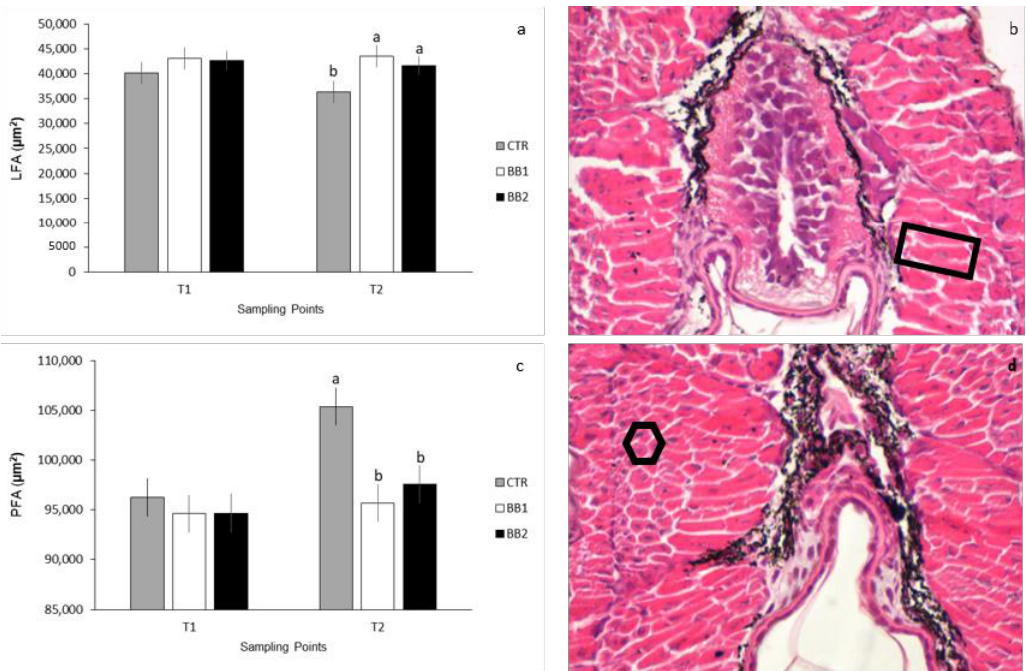
Figure 5. ( a ) Quantitative representation of lamella-shaped fibres area, LFA; ( b ) HE staining representative figures for yolk-sac full absorption, at BB1; rectangle indicating lamella-shaped fibre; ( c ) quantitative representation of and polygonal cells area, PFA. Area expressed in µm 2 ; n = 18/group; a,b Means with different superscripts differ significantly between treatments ( p < 0.05); ( d ) HE staining representative figures for yolk-sac full absorption, at BB2; hexagon indicating polygonal cell.